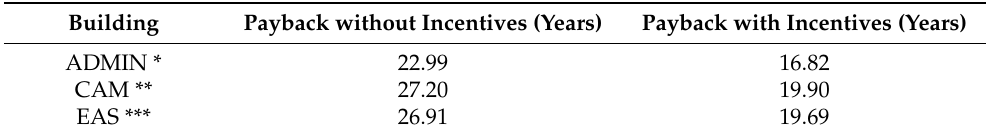
Table 5. Payback time considering incentives for optimum layout of a PV system in the ADMIN, CAM, and EAS buildings.